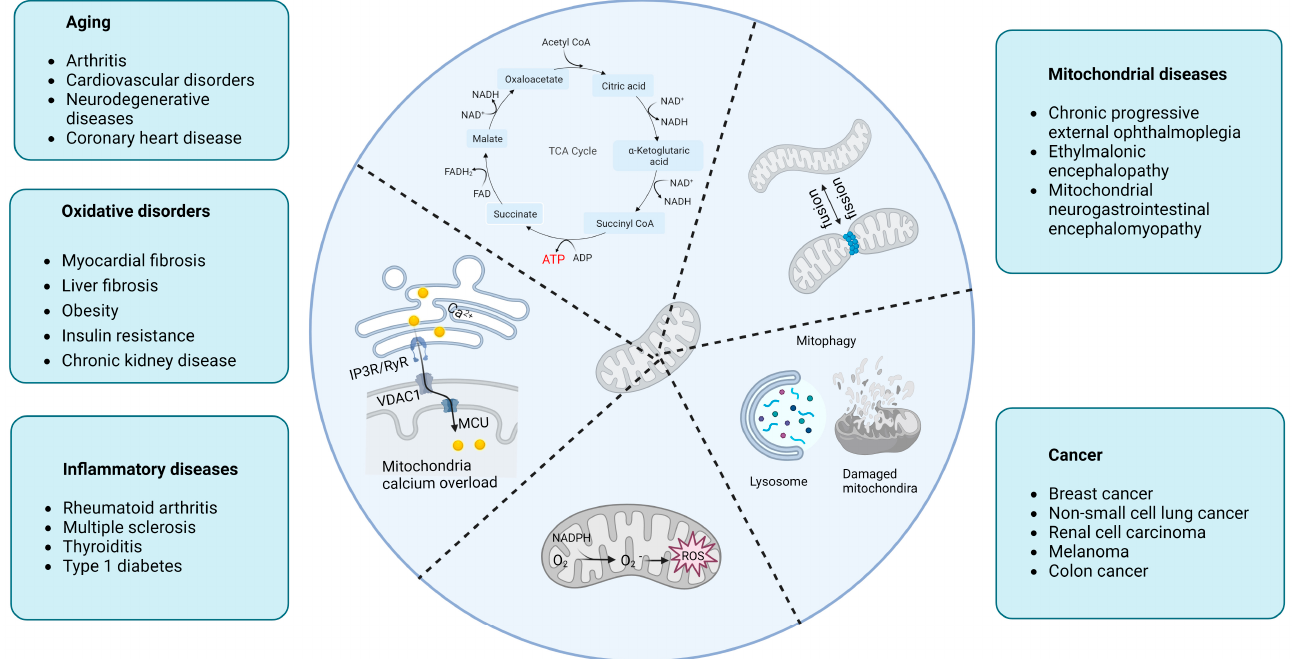
Figure 1. Central roles of mitochondria in human diseases. Abbreviations: CoA, coenzyme A; NADH, nicotinamide adenine dinucleotide; ATP, adenosine triphosphate; ADP, adenosine diphosphate; FADH2, flavine adenine dinucleotide; TCA, tricarboxylic acid; MCU, mitochondrial calcium uniporter; VDAC1, voltage-dependent anion channel 1; IP3R, inositol 1,4,5-trisphosphate receptor; RyR, ryanodine receptor.